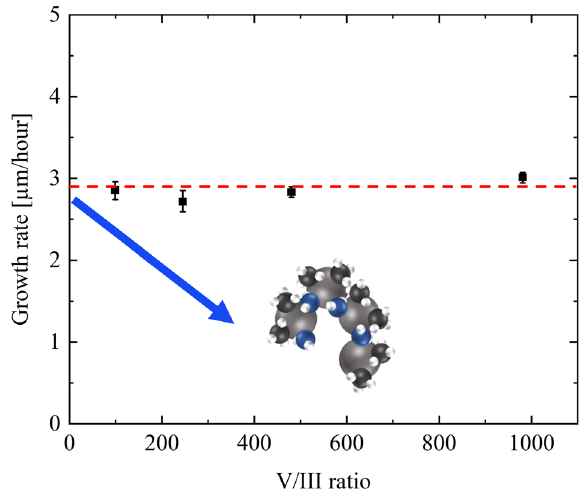
Figure 2. The AlN growth rate as the function of the V/III ratio: The growth rate decreases when the parasitic reaction in the vapor phase, including in the blue arrow. These data indicate the AlN growth at 1700 °C is unaffected by the parasitic response in this experiment.